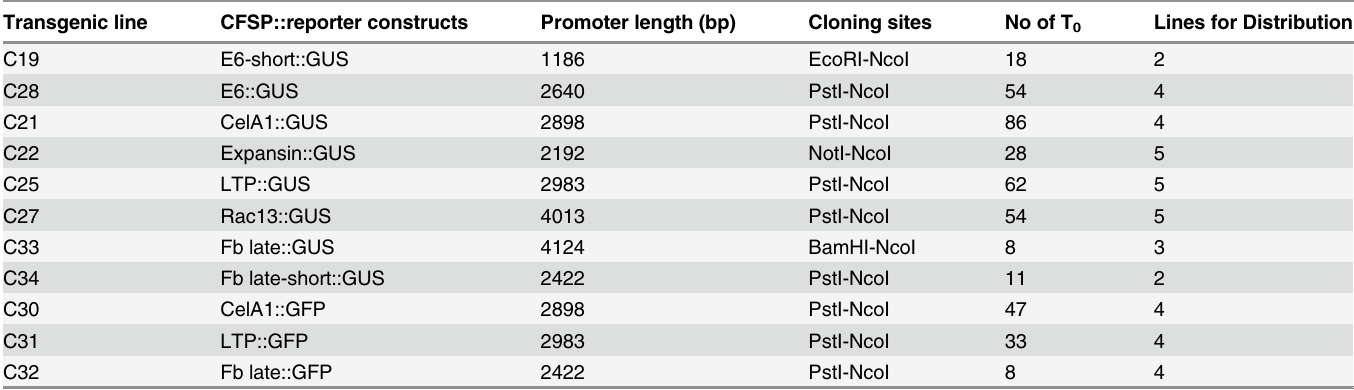
Table 1. Information about CFSP::Reporter constructs and transgenic lines. Transgenic